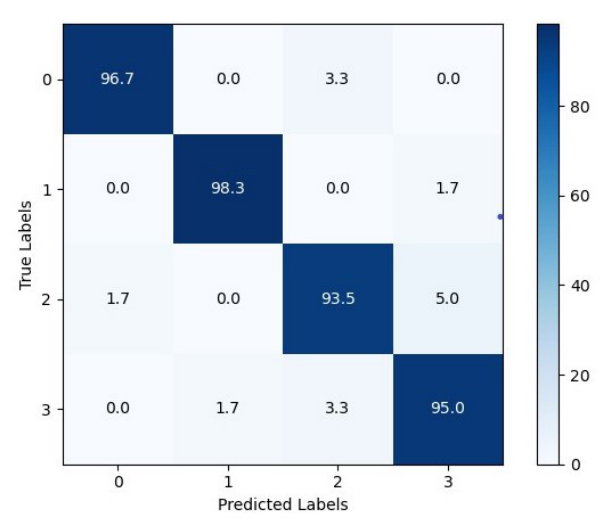
Figure 11. Confusion matrix of